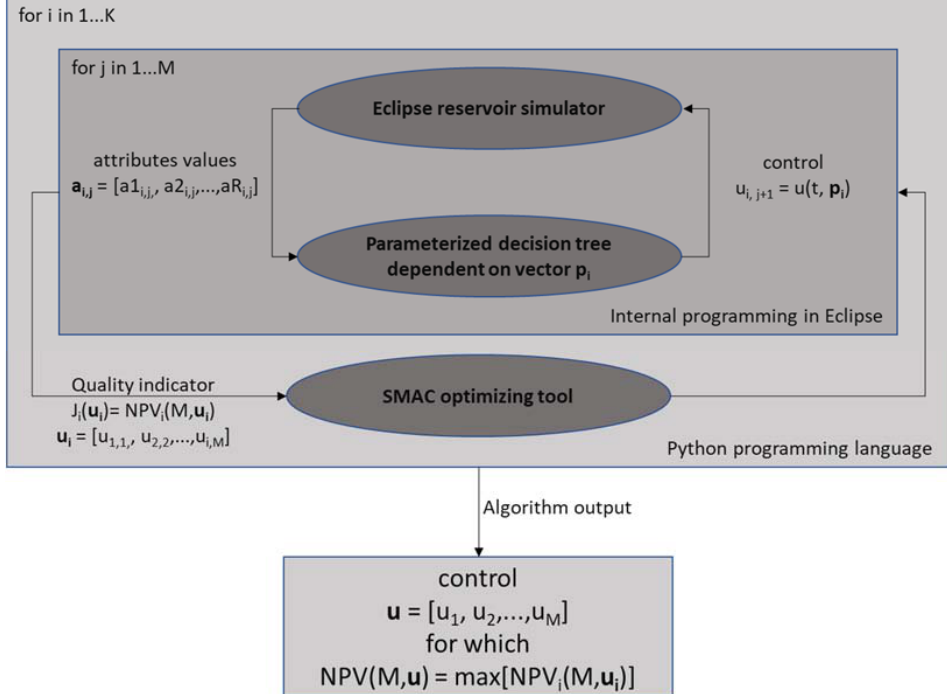
Figure 3. Diagram showing the principle of the developed tool.